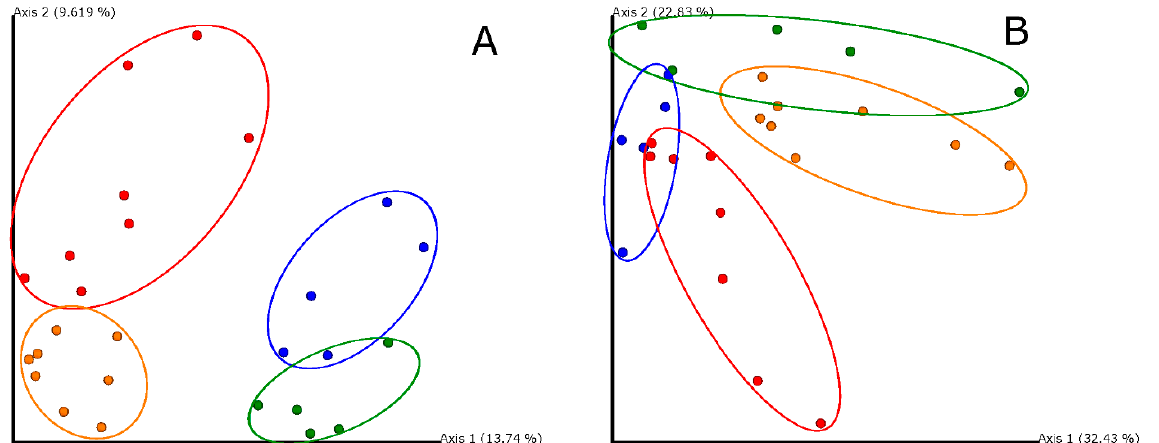
Figure 5. Principal Coordinate Analysis based in Unweighted UniFrac ( A ) and Weighted UniFrac ( B ) distance matrixes exploring the effects in the bacterial gut community of the supplementation with a commercial Alliaceae extract in laying hens’ diet (red: ileum, treated hens; orange: cecum, treated; blue: ileum, control; green: cecum, control). Circles surround samples from similar gut region and treatment. Percentages show the proportion of variance explained by each axis.